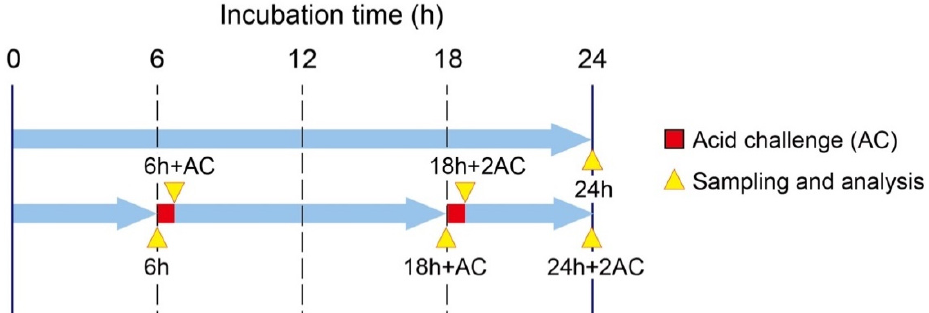
Figure 1. Experimental design showing the time schedule, treatment, and sampling. Acid challenge (AC) refers to exposure to 1M acetic acid (pH 4.5) for 30 min. Incubation and acid challenge were performed at a flow rate of 2 mL/min. Sampling and analysis were performed at the points indicated by yellow arrow heads. 6 h: 6 h of culture; 6 h + AC: A single exposure of acetic acid for 30 min after 6 h of incubation; 18 h + AC: The specimen was exposed to acidic solution after 6 h of incubation and then cultured up to 18 h; 18 h + 2AC: A second exposure of acetic acid after 18 h of incubation; 24 h: 24 h of culture without acidic treatment; 24 h + 2AC: The specimen was exposed to acidic solution after 6 h and 18 h of incubation during 24 h of culture.